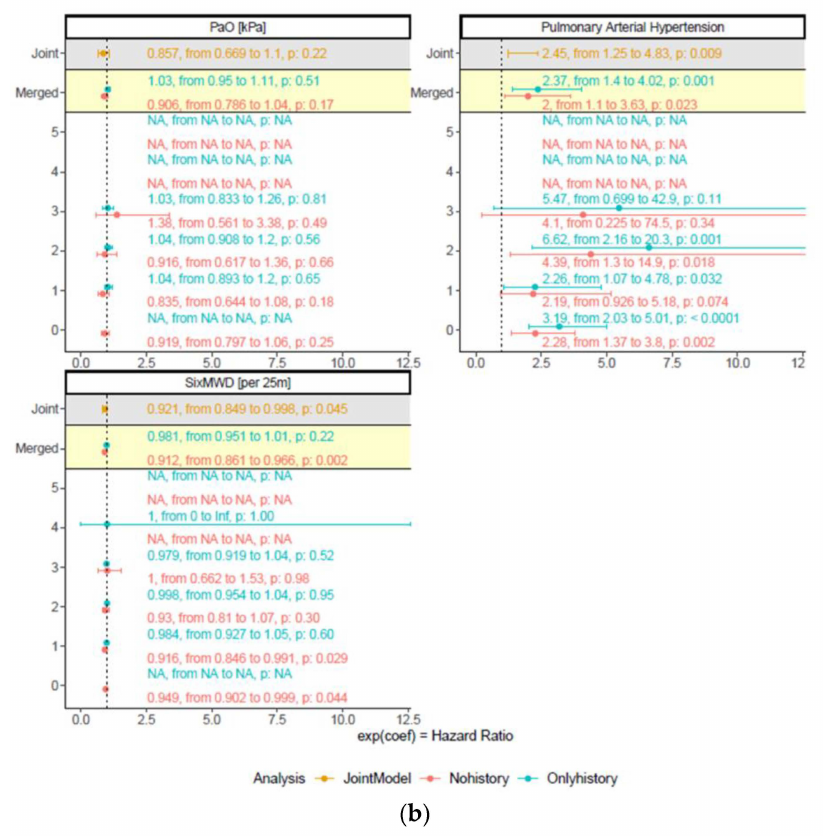
Figure 3. ( a ) Presentation of the variables age, CAT, FEV 1 % pred., and heart disease of the final multivariable cox models. Results for each variable out of the three models are presented within one box (white, yellow, and grey areas). Analysis of prediction value for each visit (white area, visit 0–5), merged cox model (yellow area), and joint model (grey area) were used to compare predictor robustness over time. Non-history (red) and history-only (blue) values are presented for each visit (0–5) and the merged cox model. Results are presented as hazard ratio (95% confidence interval) and p -value. Age at baseline (presented as “per 10 years” unit) and pulmonary hypertension are independent, robust predictors of mortality. ( b ) Presentation of the variables PaO 2 , pulmonary hypertension, and 6 min walking distance of the final multivariable cox models. Results for each variable out of the three models are presented within one box (white, yellow, and grey areas). Analysis of the prediction value for each visit (white area, visit 0–5), merged cox model (yellow area), and joint model (grey area) were used to compare predictor robustness over time. Non-history (red) and history-only (blue) values are presented for each visit (0–5) and the merged cox model. Results are presented as hazard ratio (95% confidence interval) and p -value. Age at baseline (presented as “per 10 years” unit) and pulmonary hypertension are independent, robust predictors of